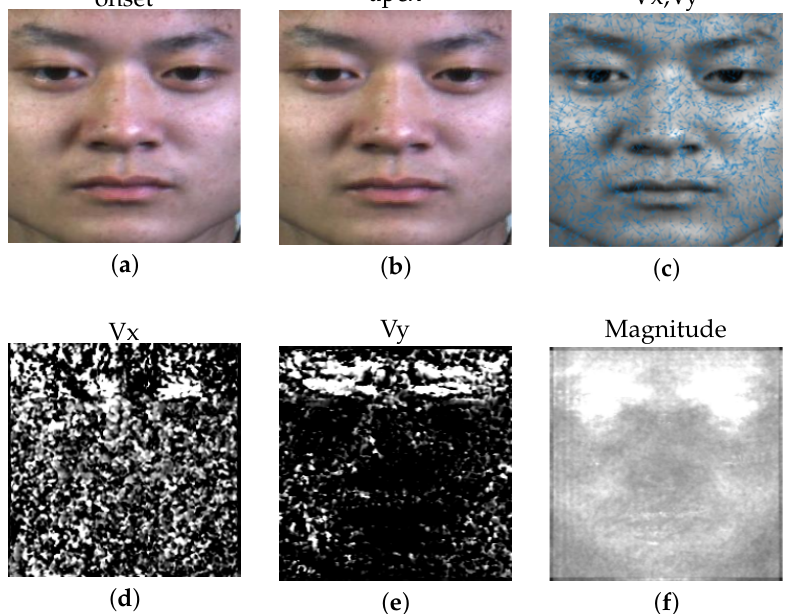
Figure 3. Optical flow is computed between the onset ( a ) and the apex ( b ): vectors obtained for a random sample of pixels ( c ), Vx field ( d ), Vy field ( e ) and Magnitude field ( f ).